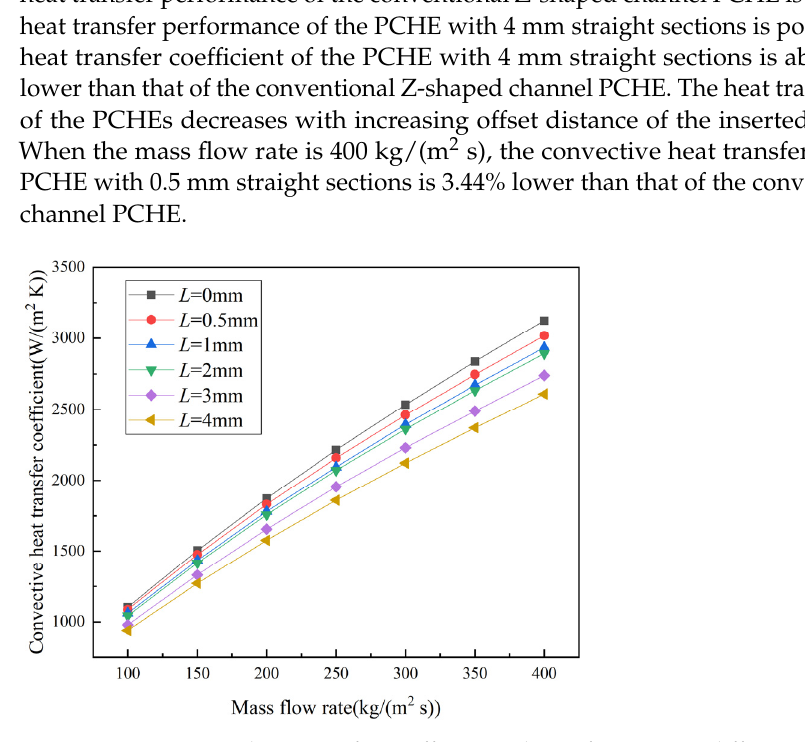
Figure 6. Pressure drop values of PCHEs at different mass flow rates for different offset distances of inserted straight sections.